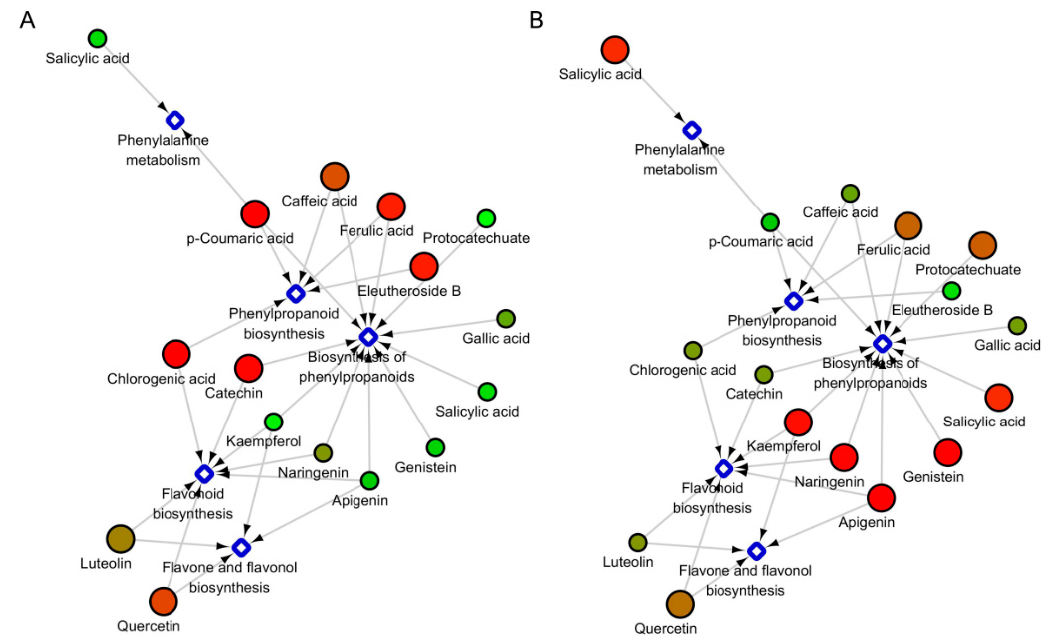
Figure 4. The associated network map of metabolites in ASH and ASS. The circles and diamonds nodes represent different metabolites and related metabolic pathways. Red indicates high abundance, whereas low relative phenolic compounds are blue. From red to green indicate abundance from high to low. Phenylpropanoid biosynthesis, Biosynthesis of phenylpropanoid, Flavonoid biosynthesis and Flavone and flavonol bilsynthesis are mutually different metabolic pathways. ( A ) ASH; ( B ) ASS.